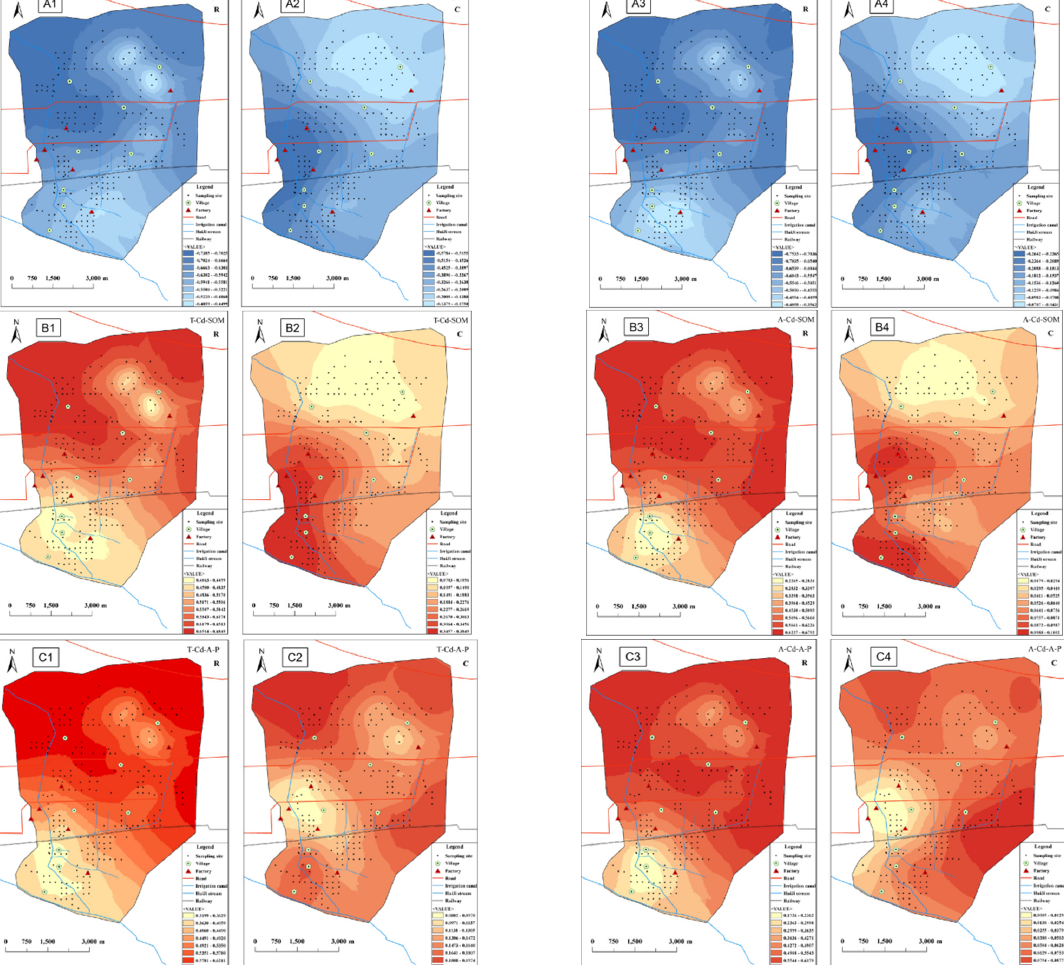
Figure 4. Spatial variation of correlation between T-Cd, A-Cd and major soil properties, as well as their influencing intensity. ( A1 ) shows spatial variation of the correlation between T-Cd and pH; ( A2 ) for spatial variation of influence intensity of pH on T-Cd; ( A3 ) for the correlation between A-Cd and pH; ( A4 ) for influence intensity of pH on A-Cd; ( B1 ) for the correlation between T-Cd and SOM; ( B2 ) for influence intensity of SOM on T-Cd; ( B3 ) for the correlation between A-Cd and SOM; ( B4 ) for influence intensity of SOM on A-Cd; ( C1 ) for the correlation between T-Cd and A-P; ( C2 ) for influence intensity of A-P on T-Cd. ( C3 ) for the correlation between A-Cd and A-P; ( C4 ) for influence intensity of A-P on A-Cd.